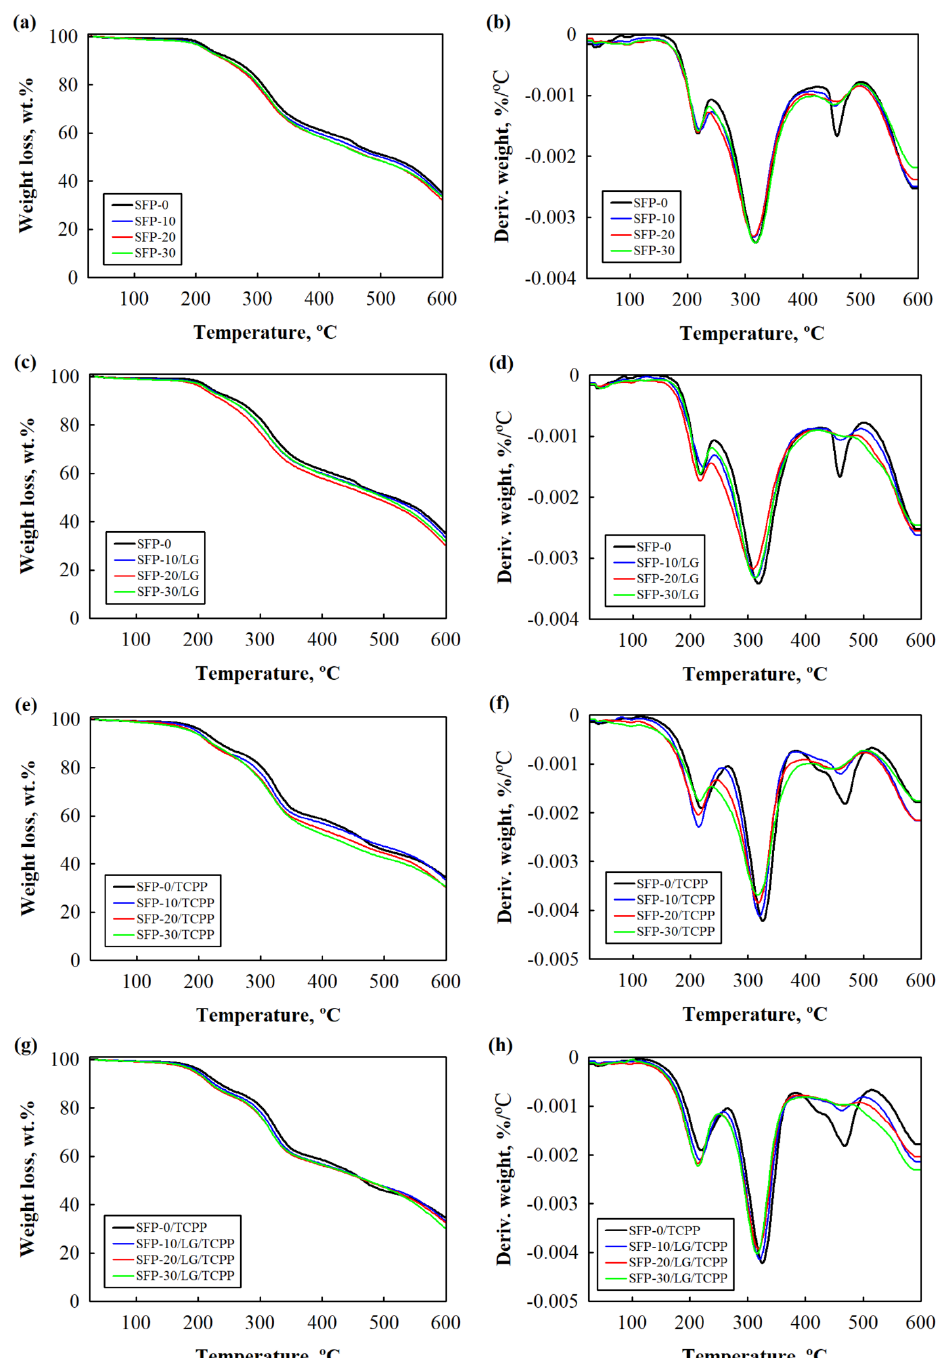
Figure 3. Thermal stability of the control PUR and flame retardant PUR foams: ( a , b ) TGA and DTG curves of PUR foams with SFP filler; ( c , d ) TGA and DTG curves of PUR foams with LG-modified SFP filler; ( e , f ) TGA and DTG curves of flame retardant PUR foams with SFP filler; and ( g , h ) TGA and DTG curves of flame retardant PUR foams with LG-modified SFP Table 3. Thermal degradation parameters of PUR and flame retardant PUR foams.